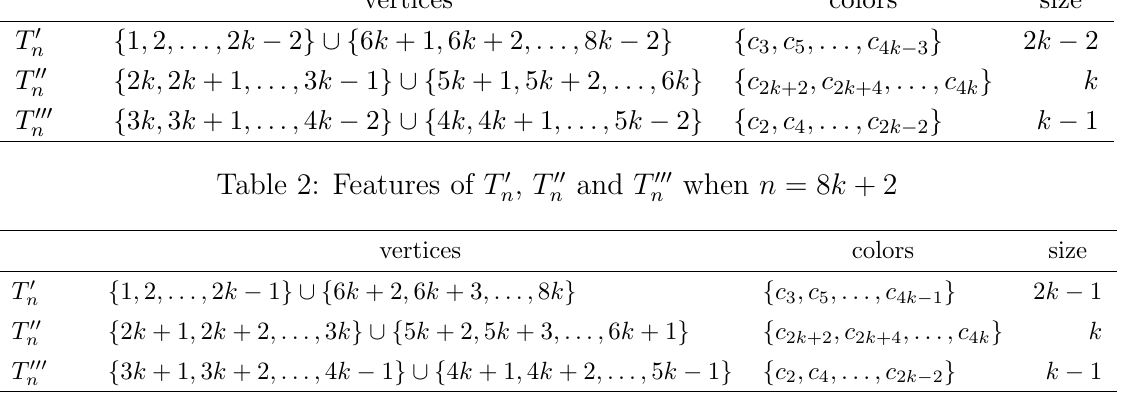
Table 1: Features of T (cid:48) , T (cid:48)(cid:48) , and T (cid:48)(cid:48)(cid:48) when n = 8 k n n n vertices colors size